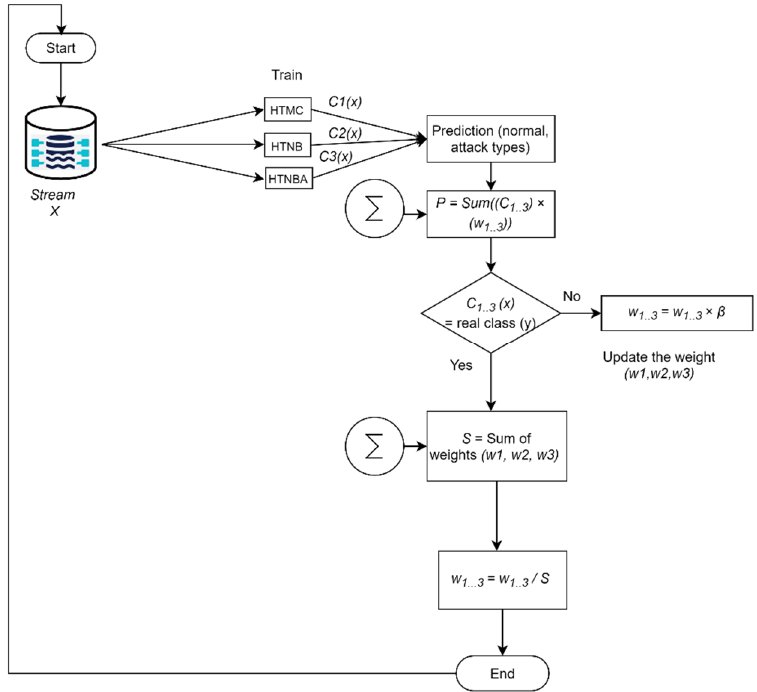
Figure 4. The flowchart of the proposed ensemble WHTE method.